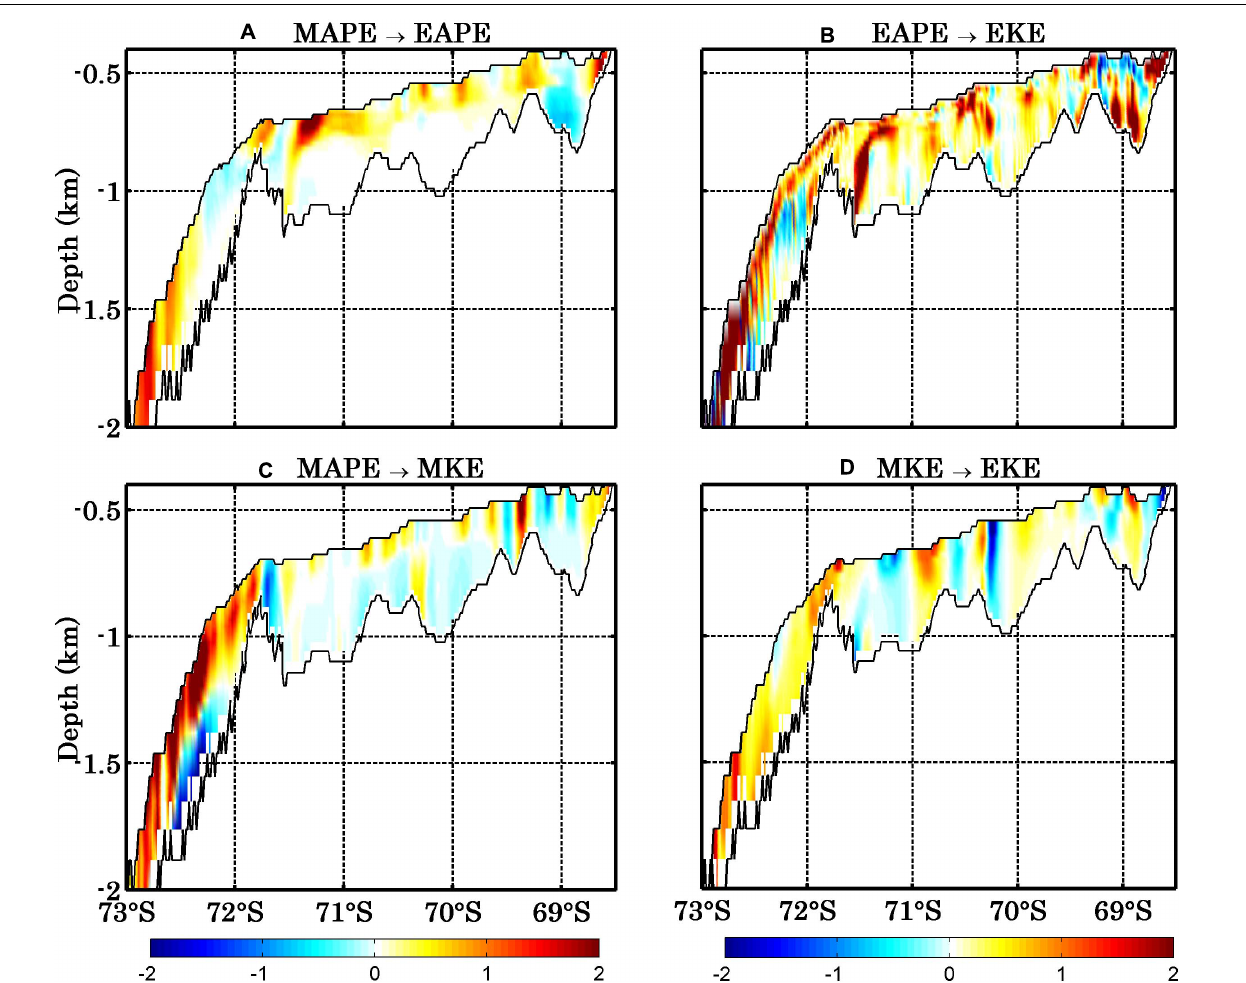
FIGURE 9 | The annual mean vertical distributions of energy conversion rates from MAPE to EAPE (1 × 10 − 3 W m − 3 ) (A) , EAPE to EKE (1 × 10 − 3 W m − 3 ) (B) , MAPE to MKE (1 × 10 − 2 W m − 3 ) (C) , and MKE to EKE (1 × 10 − 3 W m − 3 ) (D) , along the sections marked in Figure 9A .